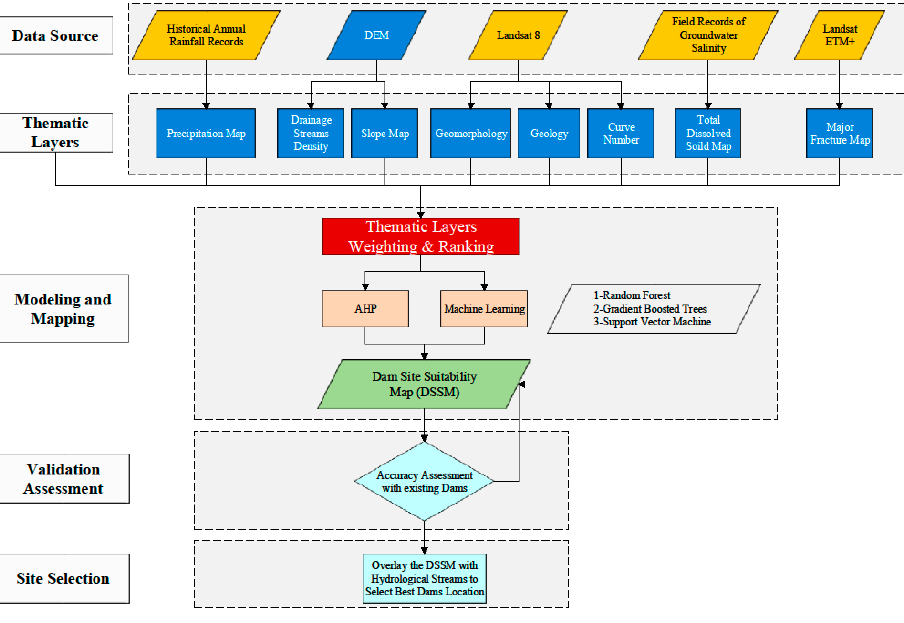
Figure 2. Methodology Framework.